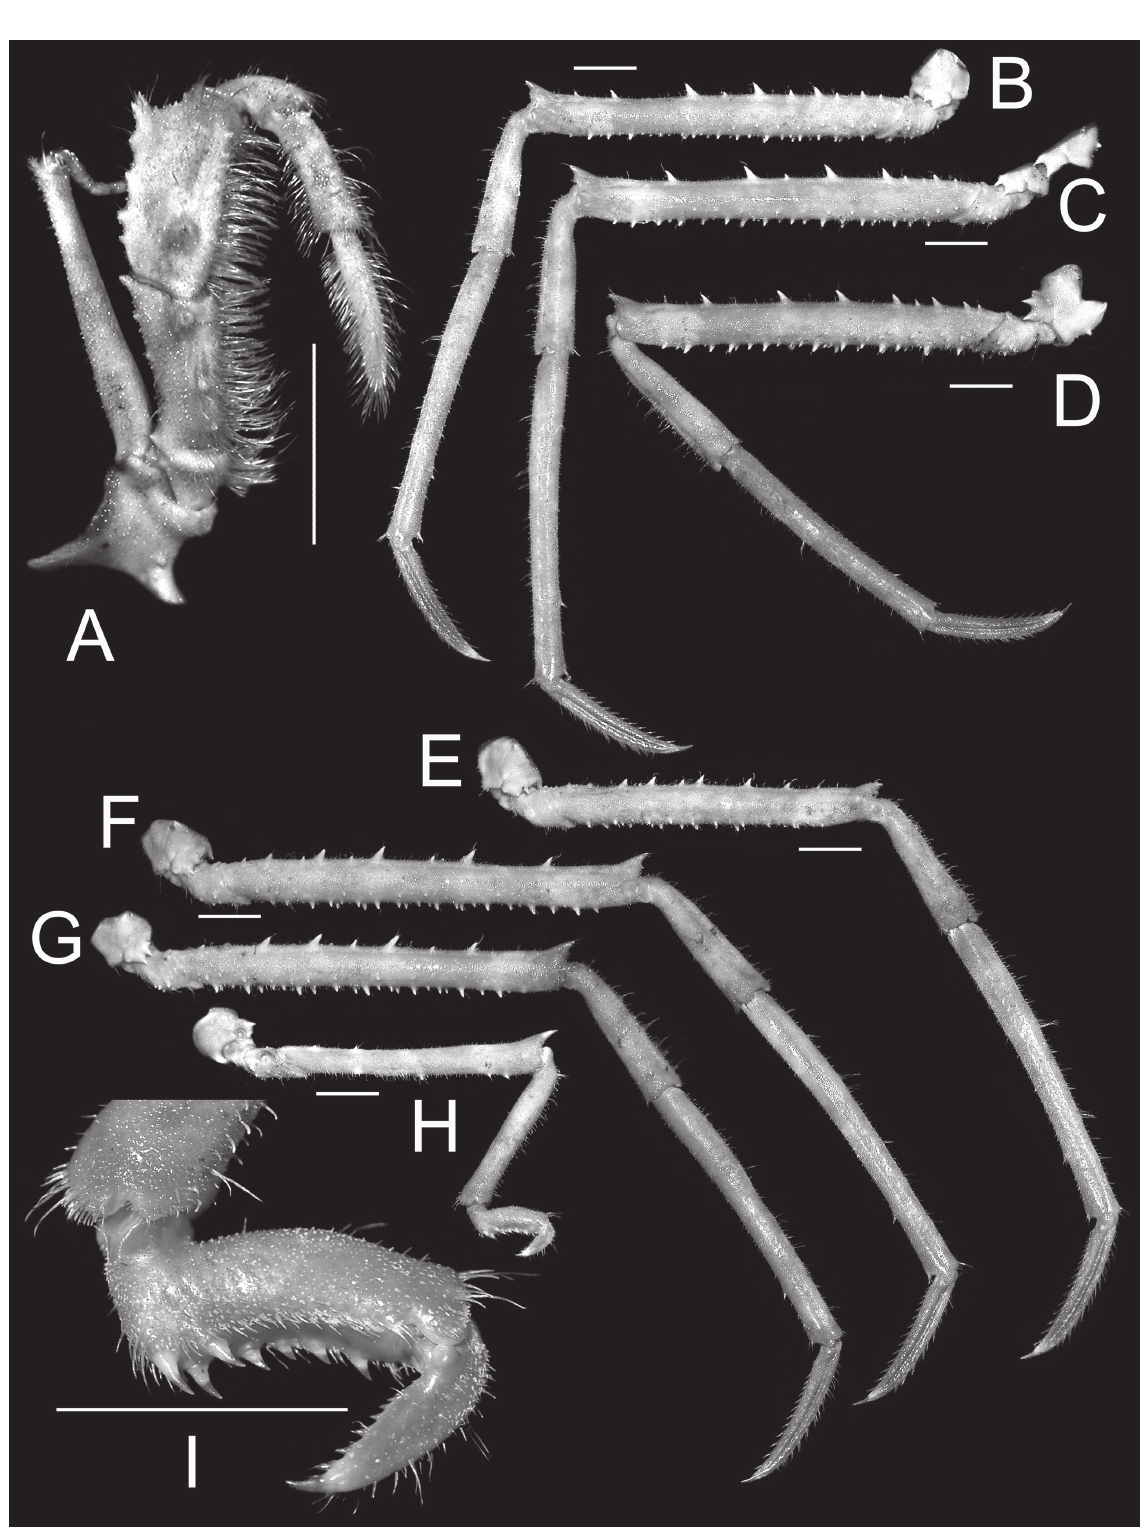
Fig. 13. Moloha tumida sp. nov. Holotype, ♂ (cl 55.7 mm, cw 50.6 mm) (DABFUK), Kerala, India. A . Right third maxilliped. B – D . Left P2–P4, respectively. E – H . Right P2–P5, respectively. I . Right P5 subchelate dactylus and propodus. Scale bars = 10